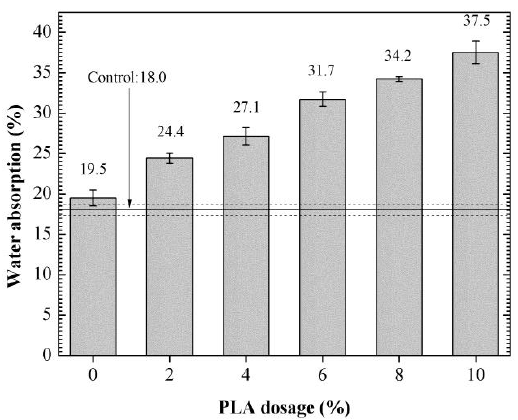
Figure 8. Water absorption of the 200 °C-heated specimens of control and SDTSMs with different PLA dosages.